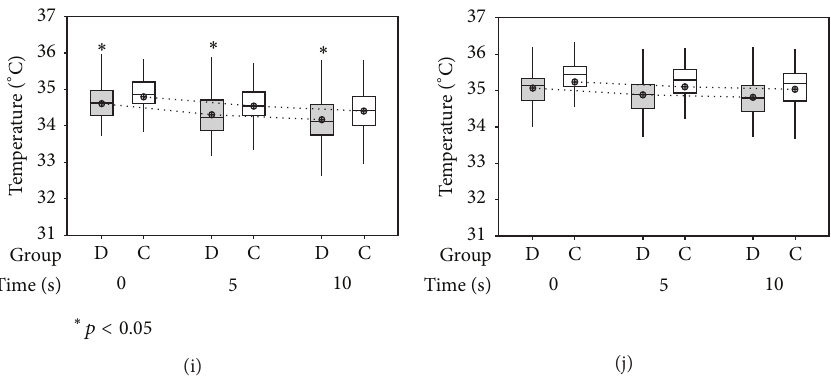
Figure 2: (Static measures) box plots showing comparison of absolute OST at 0 s, 5 s, and 10s: (a) GCC; (b) MOST; (c) Min 𝑇 ; (d) Max 𝑇 ; (e) T1; (f) T4; (g) CT; (h) LT; (i) LN; and (j) CN in (grey box) dry eye subjects and (white box) controls. The results were expressed as median and mean ± SD. Mean-connecting-lines are represented by dotted lines to show the change in mean over 0 s, 5 s, and 10 s. 𝑝 values are shown using one-way ANOVA at 95%